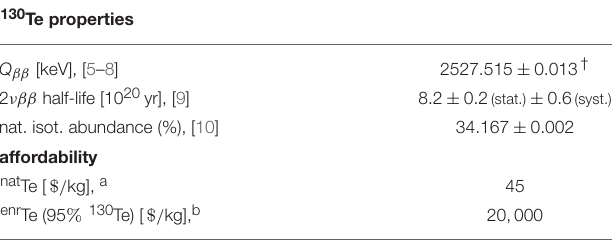
TABLE 1 | Relevant features of 130 Te for the search of 0 νββ .